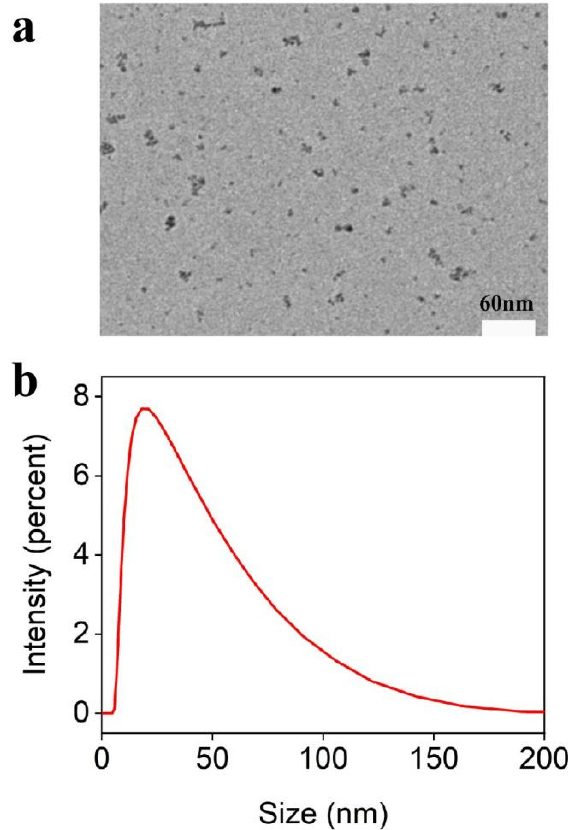
− CeO 2 sample used in this